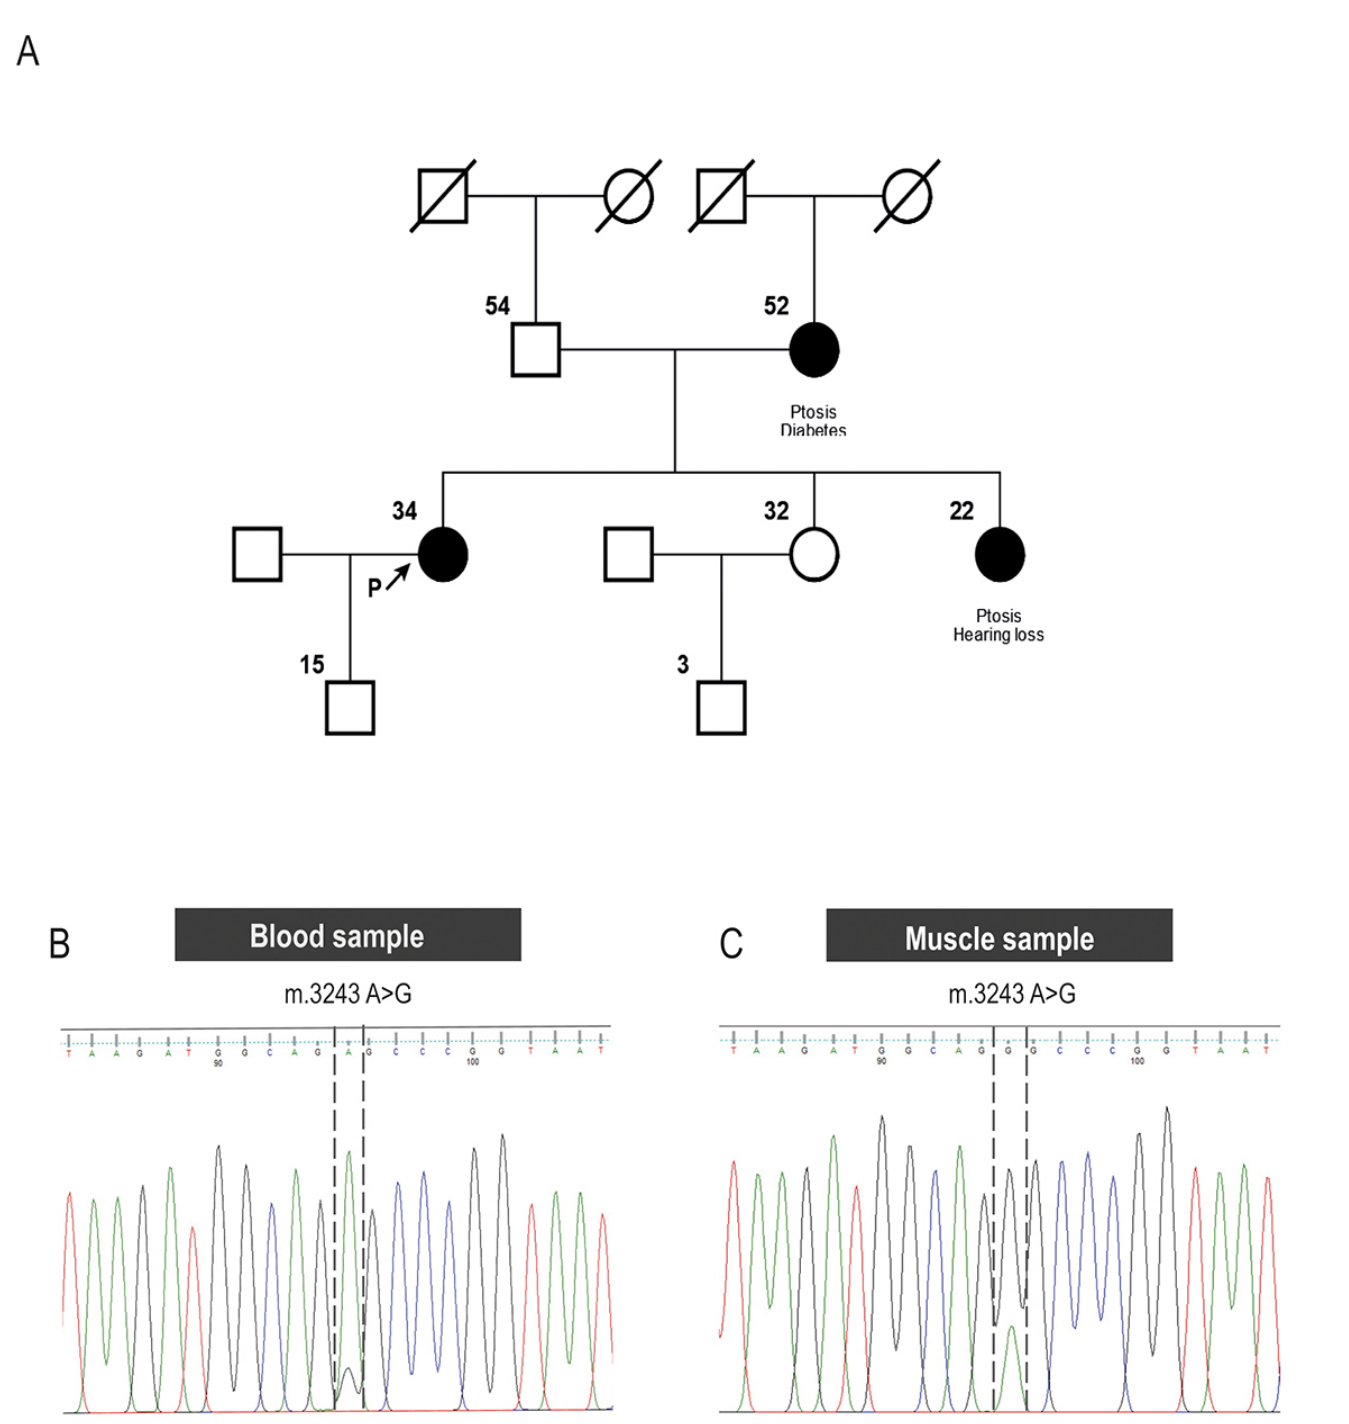
Figure 2. (a) Pedigree Chart. Arrow indicates index case. Numbers over figures corresponded to current age/age at onset . (b) Sanger Sequencing in blood sample showing identified variants in the patient. (c) Sanger Sequencing in muscle sample showing identified variants in the